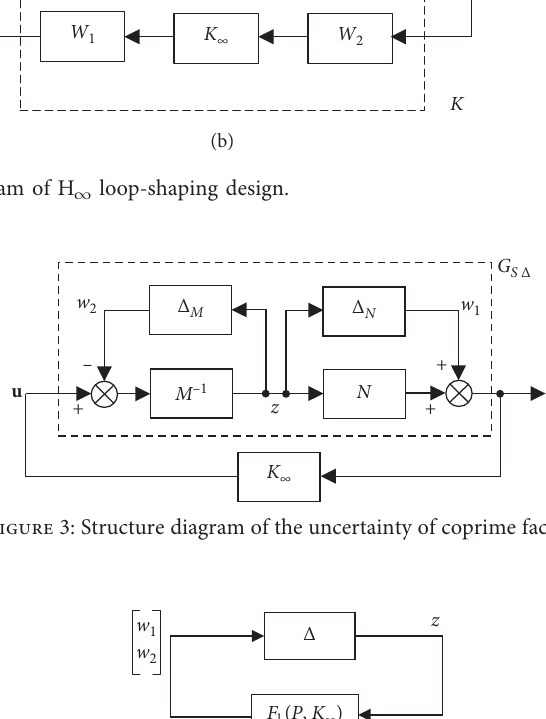
Figure 4: System structure diagram based on robustness